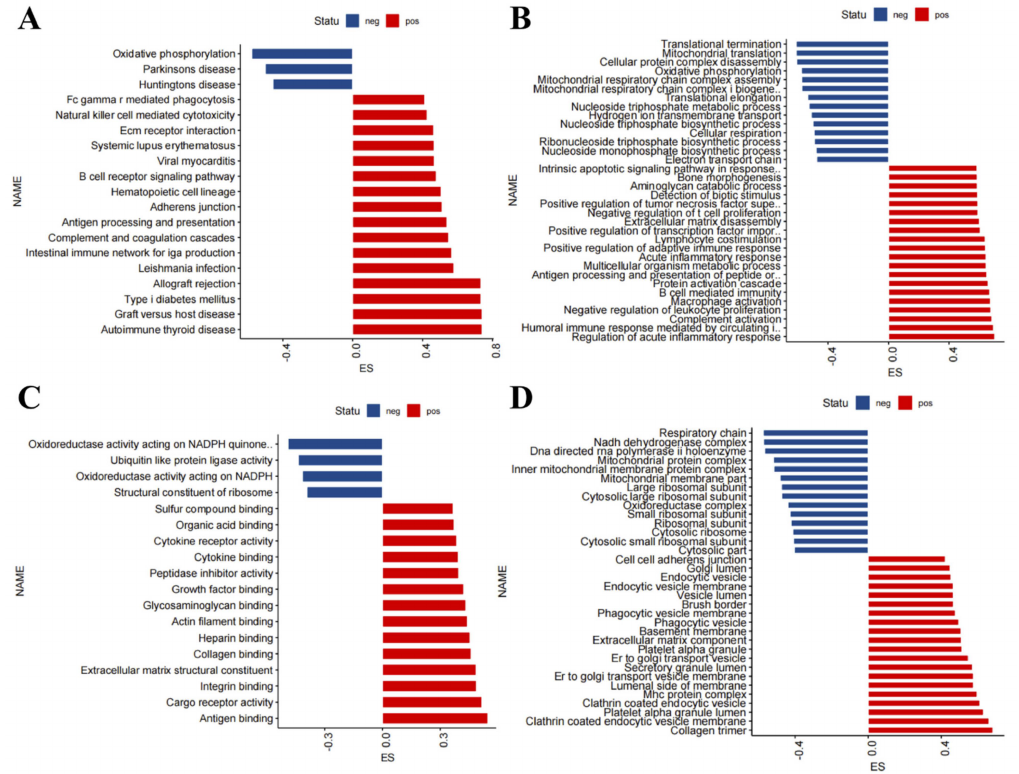
Figure 4. Gene set enrichment analysis (GSEA) of differentially expressed genes (DEGs) in the nerve tissue of amyotrophic lateral sclerosis (ALS) patients. GSEA of DEGs in the nerve tissue of ALS patients based on ( A ) KEGG pathways, ( B ) Gene Ontology (GO) biological process terms, ( C ) GO molecular function terms, and ( D ) GO cellular component